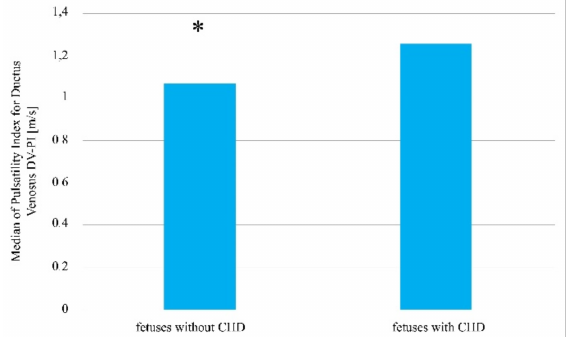
Figure 2. The venous flow rate in fetuses with and without a diagnosed congenital heart defect amongst patients who became pregnant without using assisted reproduction techniques. * Statistically significant difference (Mann–Whitney U test; p <